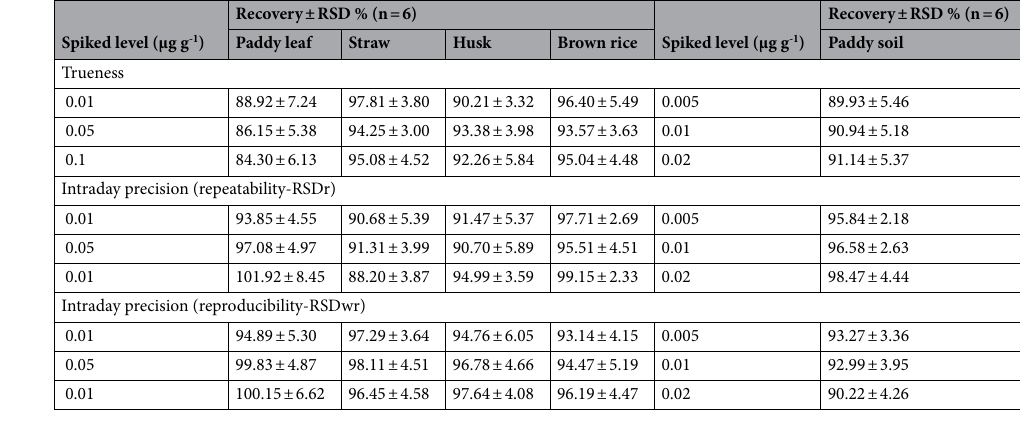
Table 3. The recovery of chlorantraniliprole in paddy leaf, straw, husk, brown rice and soil.